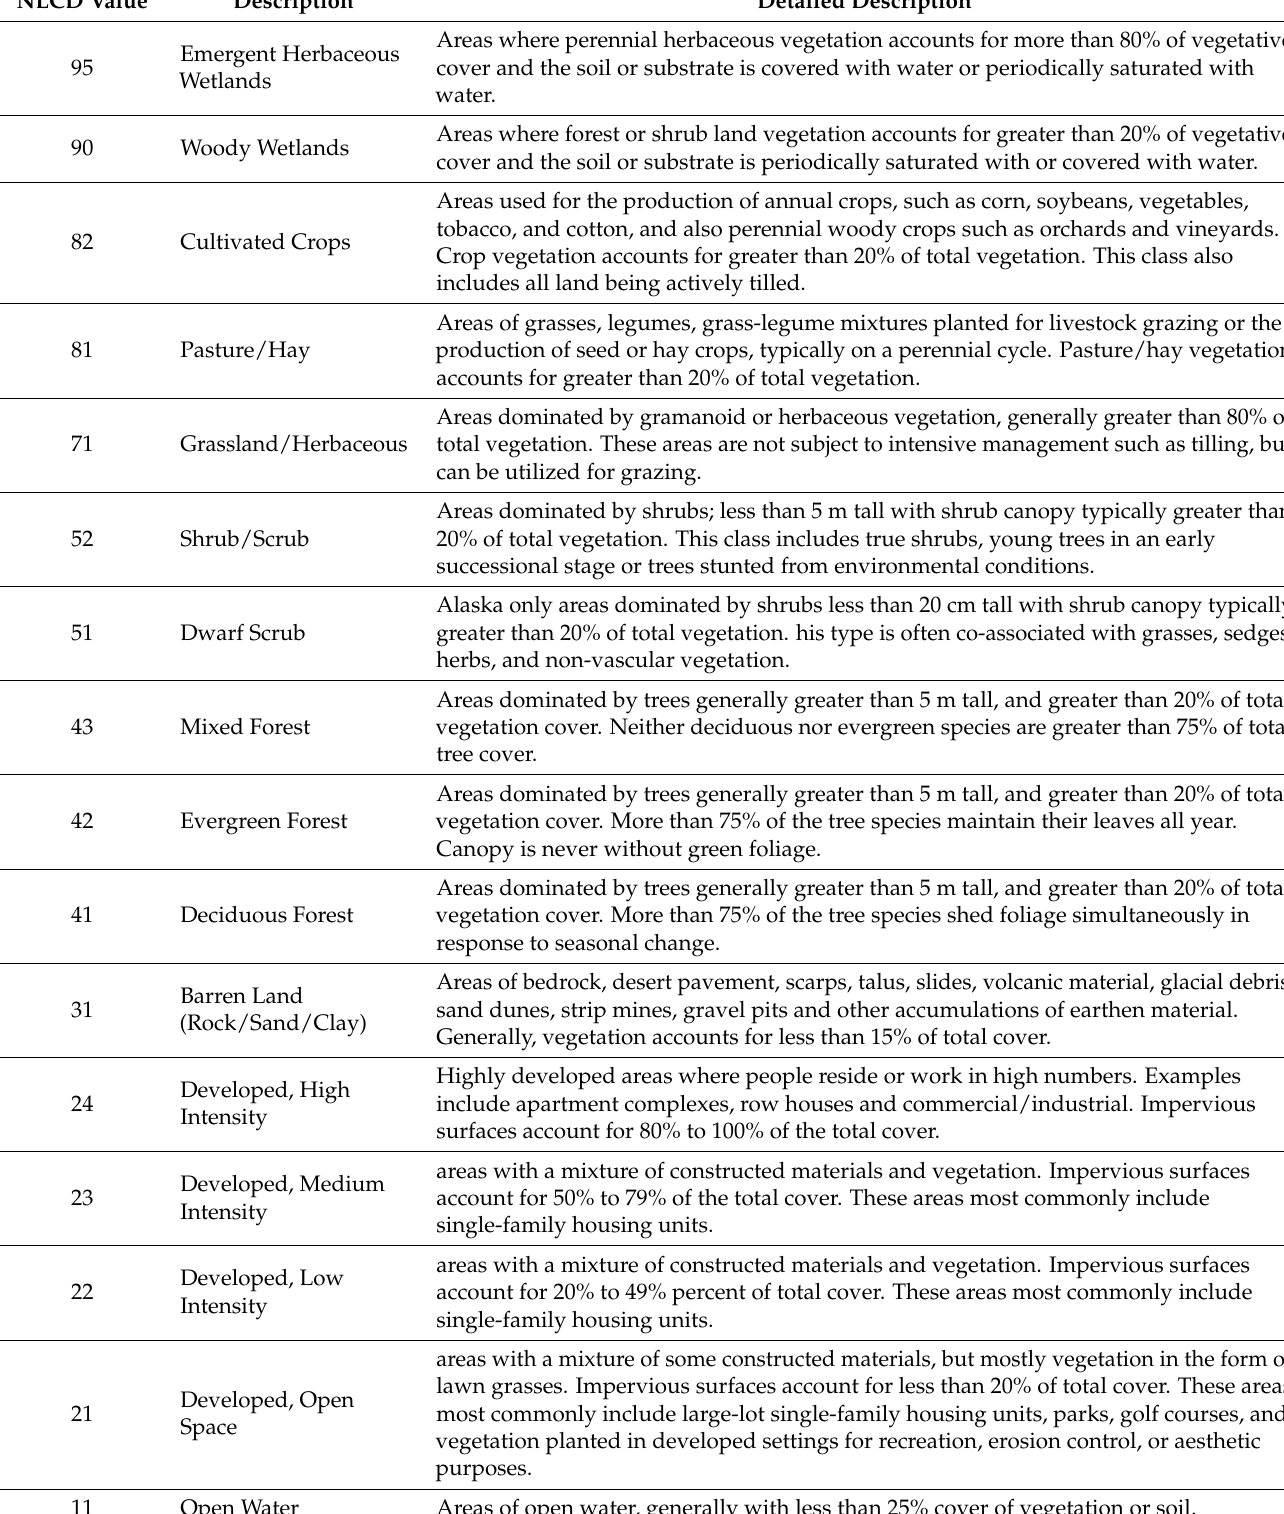
Table 1. NLCD 2019 Classifications and detailed topology descriptions